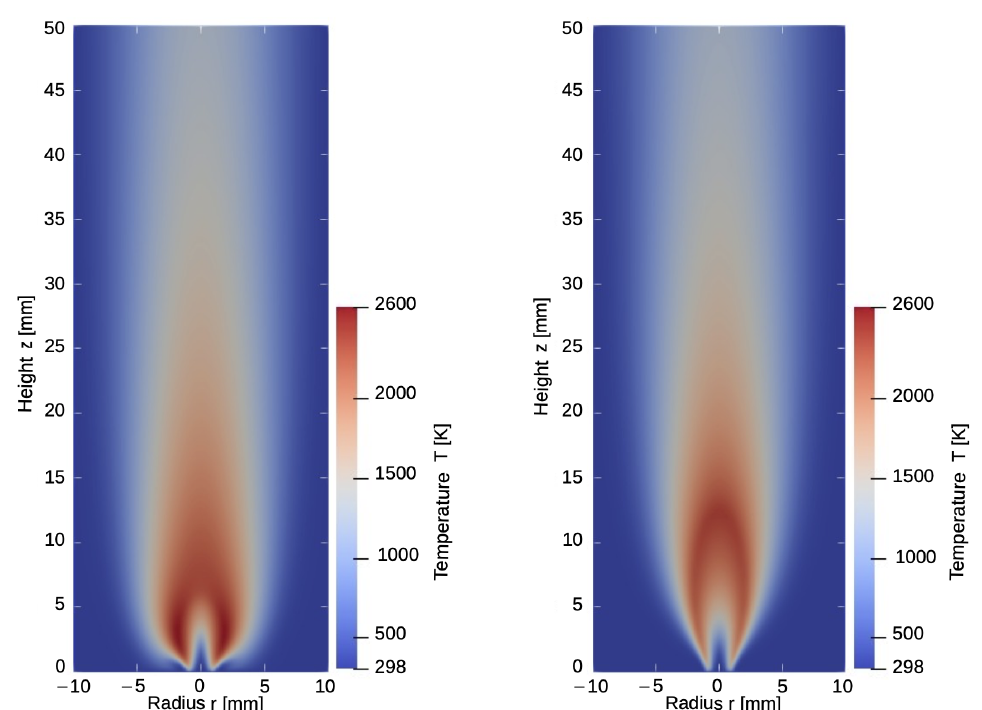
Figure 2. Temperature distribution for the model with ( left ) and without ( right ) considering compo- nent specific diffusion.